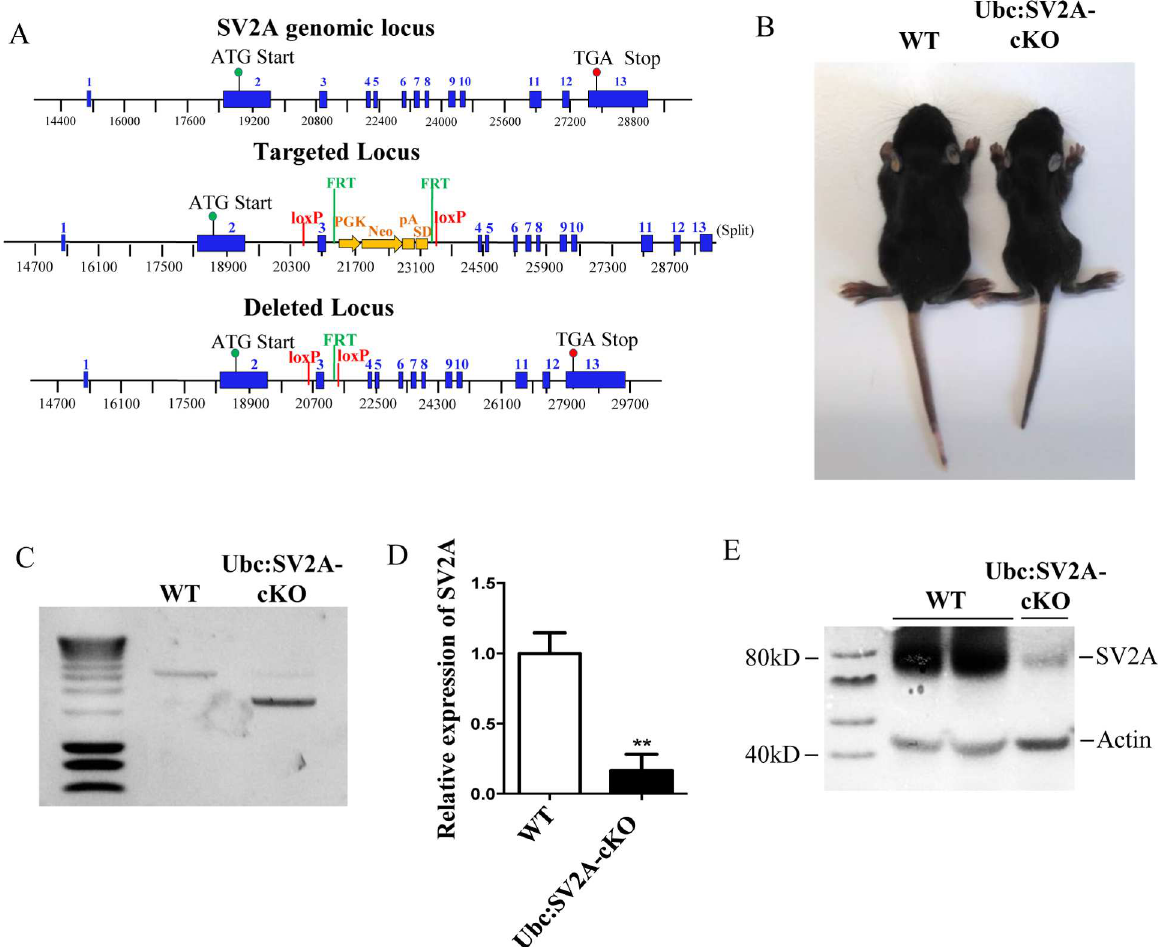
Fig 1. Conditional removal of the SV2A exon 3 in Ubiquitin-positive cells led to seizure. A: Illustration of the homologous recombination strategy used to generatethe SV2A lox/lox allele. The SV2A gene is locatedon chromosome 3, composedof 13 exons. A PGK-Neomycin selectioncassette flanked by FRT sites was inserted upstream of exon 3. FollowingFLP recombinase, the SV2A gene containedthe exon 3 flanked by LoxP sites that could be deletedusing Cre-recombinase.B: Comparisonof P12 WT and conditional SV2A-knockout (Ubc:SV2A-cKO) littermate mice. Note the reducedsize of the Ubc:SV2A-cKO mice. C: PCR genotype analysisof WT and Ubc:SV2A-cKO mouse brains (the loxed allele at 2,500bpand recombined alleleat 1,500bp).D: SV2A mRNA expressionin brains, measured by quantitative real-time PCR from WT and Ubc:SV2A-cKO mice. The level of SV2A mRNA was normalized using the level of GAPDH mRNA. All data is presentedas mean ± SEM, ** p < 0.01. E: Western blot analysesshowingthe depletionof SV2A protein in Ubc:SV2A-cKO brains. Actin was used as a control for the proteinsloadedin each protein